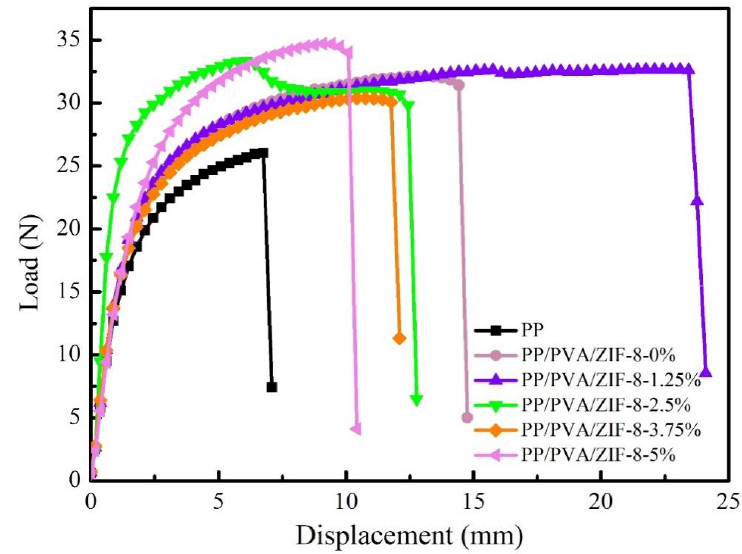
Figure 11. Displacement-Load curves of PP melt-blown membranes and PP/PVA/ZIF-8 melt-blown electrospun composite membranes.